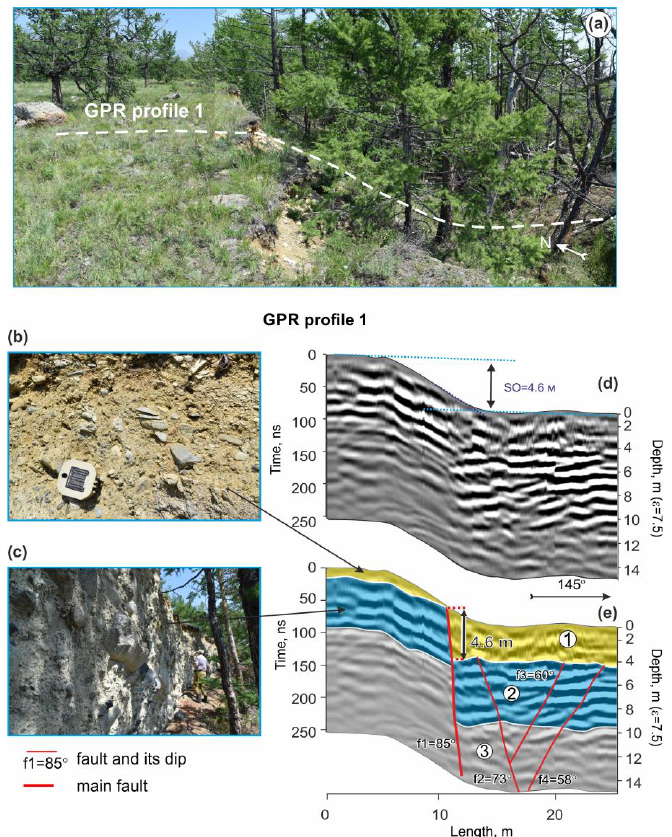
Figure 10. GPR profile 1 across the fault scarp (rupture R - 9, see location in Figures 4 and 5): ( a ) lo- cation of GPR line; ( b , c ) reddish soft - consolidated and (b ) well - consolidated grey predominantly coarse - grained ( c ) deposits; ( d ) radargram; ( e ) its interpretation with inferred ruptures, fault dis- placements (in meters), and radar facies marked by numbers in circles corresponding to layers of different dielectric properties.